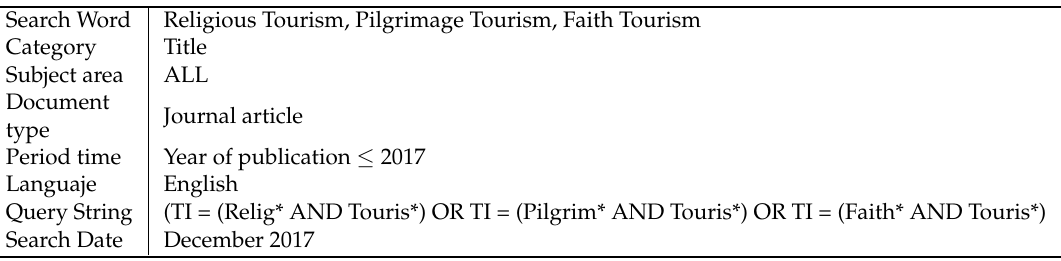
Table 2. Search Strategy in